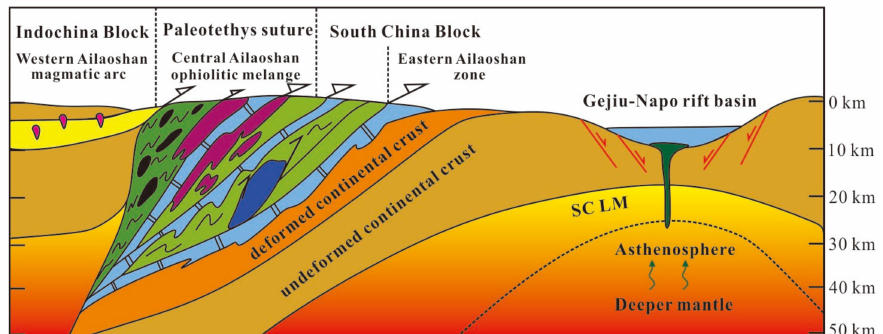
Figure 13. Schematic drawing of the tectonic evolution of the Gejiu-Napo rift event in Ailaoshan post-collisional setting (modified from [23]), SCLM: subcontinental lithospheric